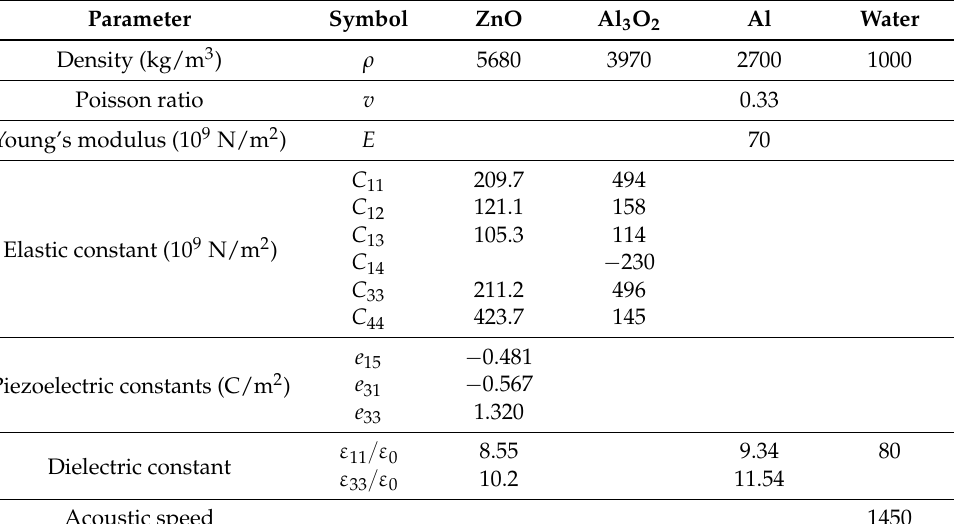
Table 1. Material parameters a .